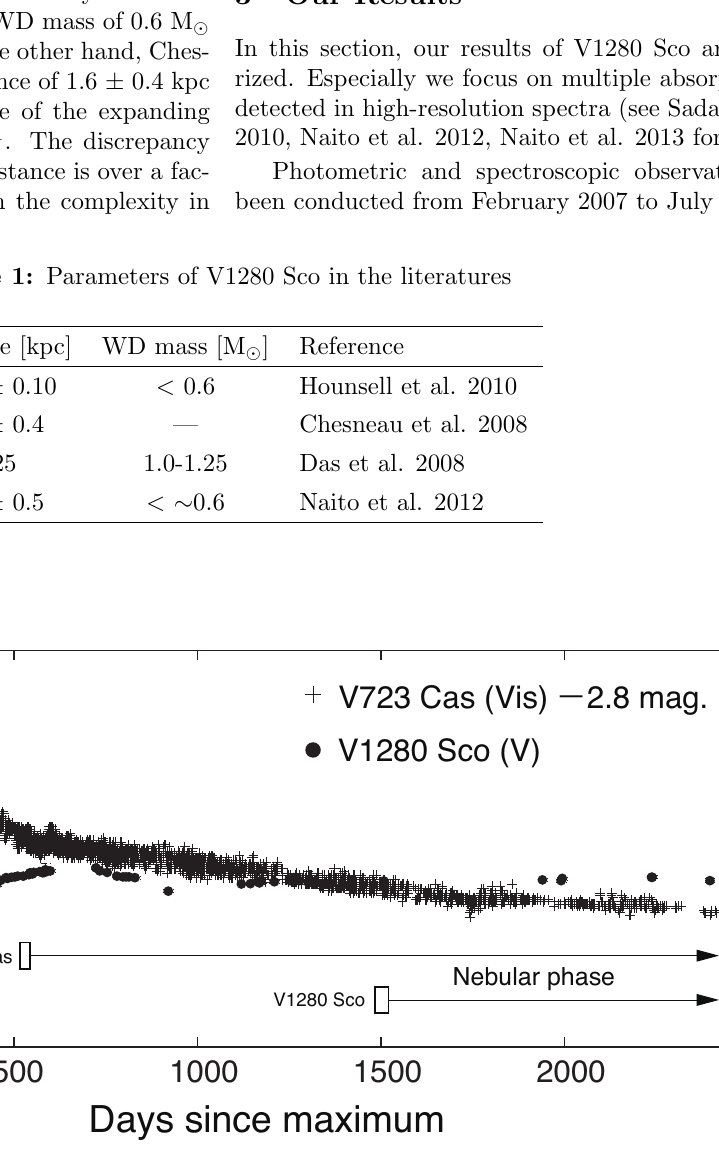
Figure 1: Comparison of light curve and nebular phase between slow novae V1280 Sco and V723 Cas. Light curve of V723 Cas is collected from AAVSO database (http://www.aavso.org) and is shifted by − 2.8 mag. V723 Cas entered the nebular phase about 18 months after maximum (Iijima 2006), while V1280 Sco took about 50 months (about three times longer than V723 Cas) to enter the nebular phase (Naito et al.